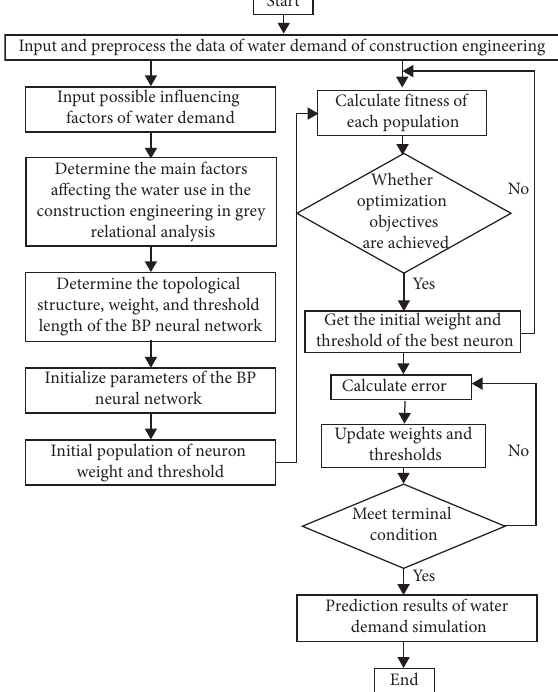
Figure 1: Flow chart of the prediction model of water